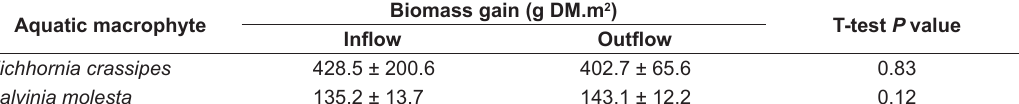
Table 3. Mean biomass gain of plants in the inflow (higher nutrient concentrations) and outflow (lower nutrients concentrations) and T-test values. (n = 3; ± standard deviation).